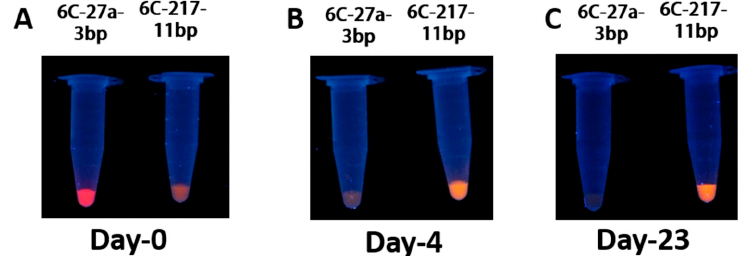
Figure 4. ( A – C ) Eppendorf tube images under UV (Ex 365 nm) illumination. All the samples were